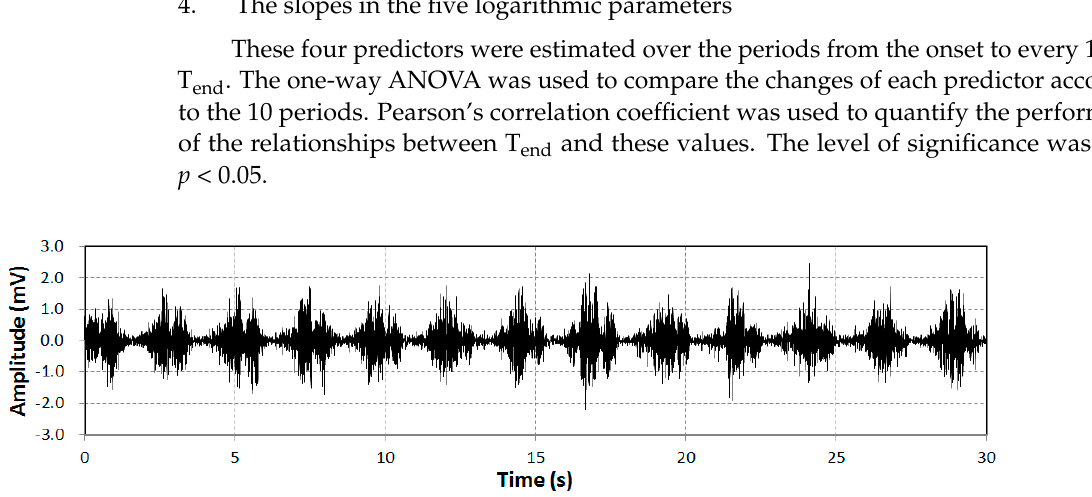
Figure 6. An example of the sEMG signal during isotonic contraction. 3.1. MVC and T end MVC was 19.1 (5.9) kgf and T end was 53.7 (19.6) s during isotonic contractions at 20% MVC. Endurance times were sorted in descending order and displayed according to the isotonic contraction sets of the 10 subjects in Figure 7.